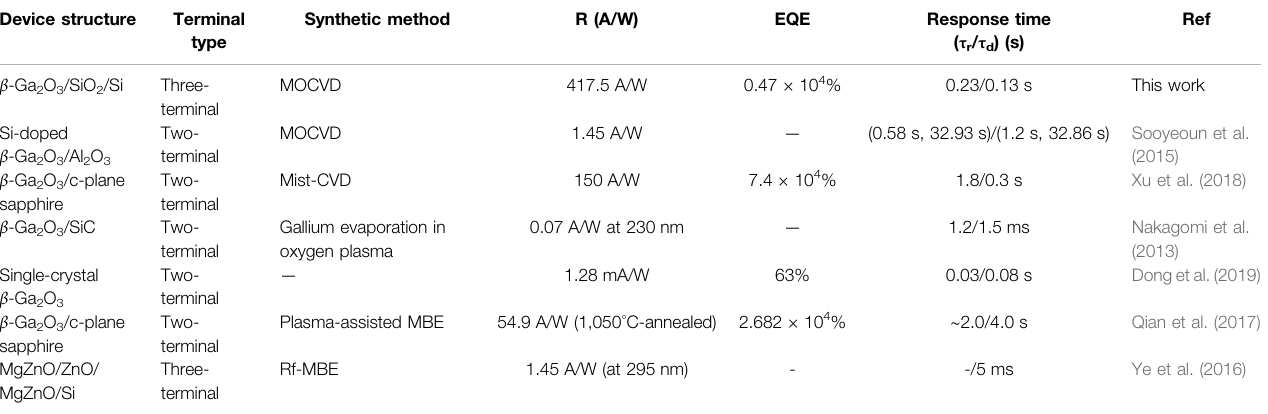
TABLE 1 | Comparison on device performance of the present device and other